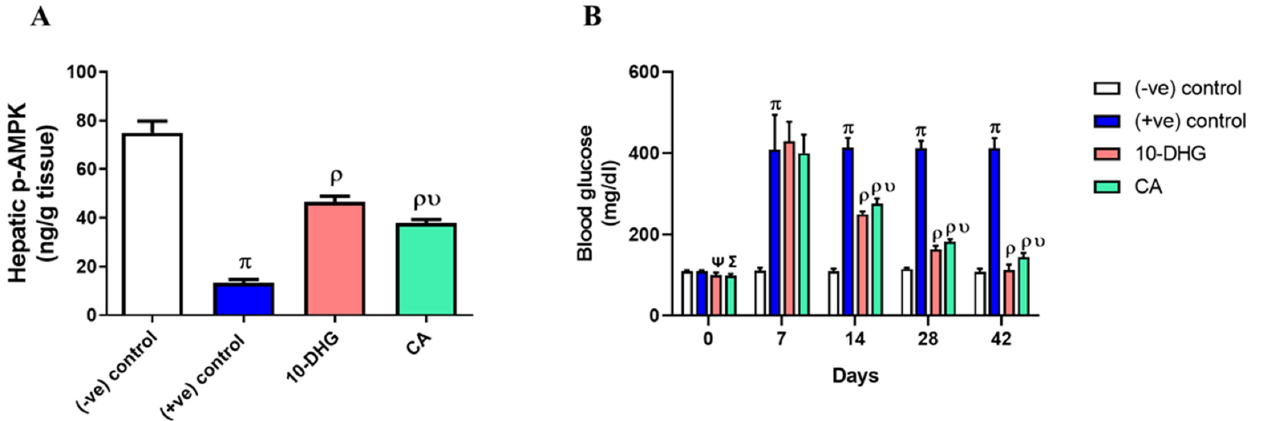
Figure 2. Effect of caffeic acid and 10-dehydrogengerdione treatment on ( A ) hepatic